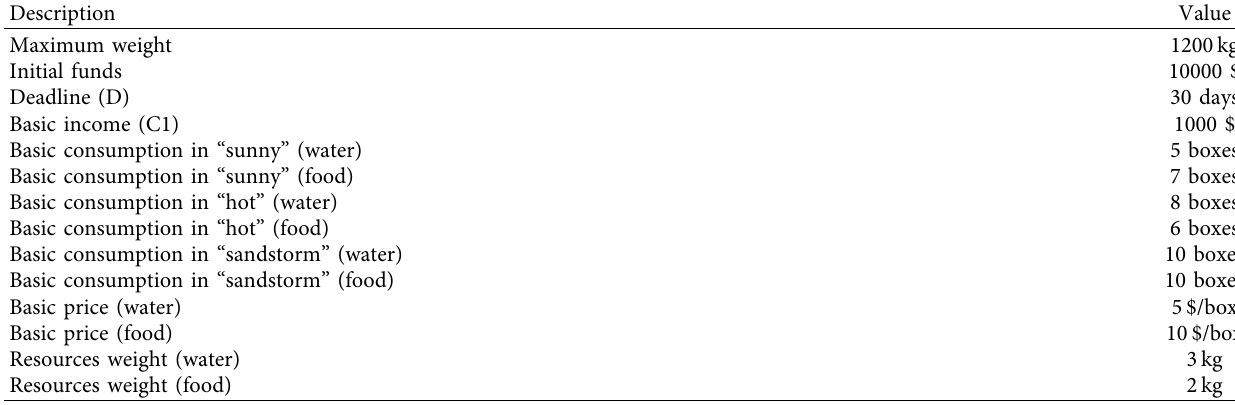
Table 3: Parameter setting.